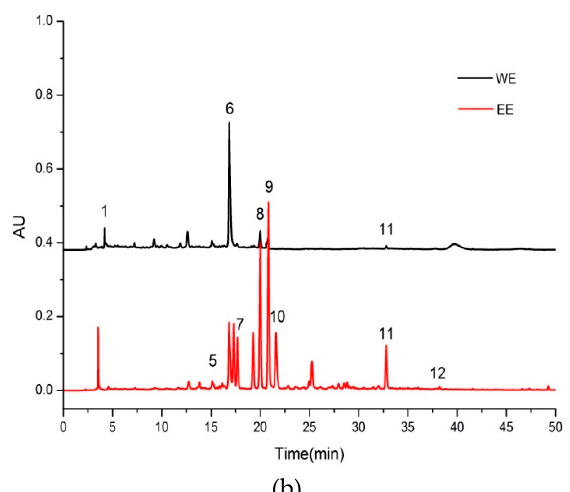
Figure 1. HPLC spectra of polyphenol standards ( a ) and polyphenols in guava leaf water extract/ethanolic extract ( b ); 1. Gallic acid, 2. Chlorogenic acid, 3. P -hydroxybenzoic acid, 4. Caffeic acid, 5. Rutin, 6. Ellagic acid, 7. Isoquercitrin, 8. quercetin-3-O- β -D-xylopyranoside, 9. Avicularin, 10. Quercitrin, 11. Quercetin, 12. Kaempferol.